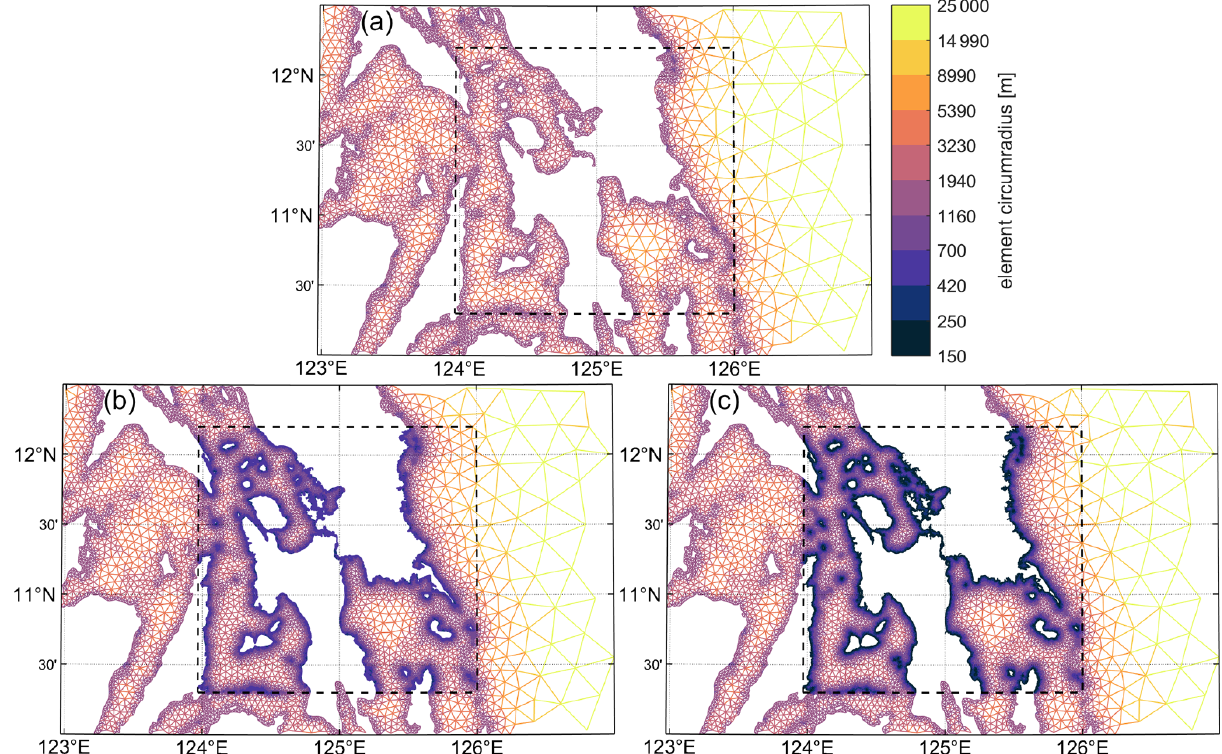
Figure 3. Comparisons of mesh triangulation and resolution (defined as the element circumradius on a Lambert conformal conic projection) in the Super Typhoon Haiyan landfall region around Leyte and Samar Island, Philippines. (a) MinEle = 1.5km (default TLS-B global mesh design), (b) MinEle = 500m local mesh refinement, (c) MinEle = 150m local mesh refinement. The black dashed boxes indicate where the local mesh refinement was applied.